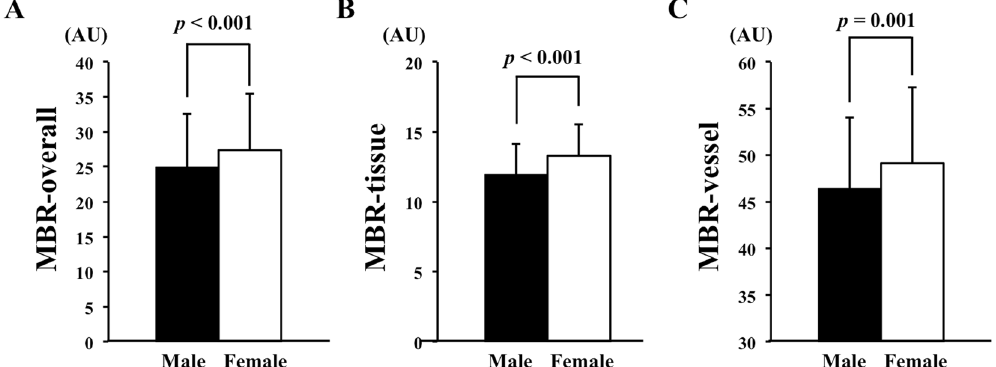
Figure 1. Differences between the sexes in the MBR determined by LSFG. The MBR of the ONH in the female group was significantly higher than that in the male group for the over-all ONH ( P < 0.001) ( A ), the tissue ( P < 0.001) ( B ), and the vessels ( P = 0.001) ( C ). Parameters